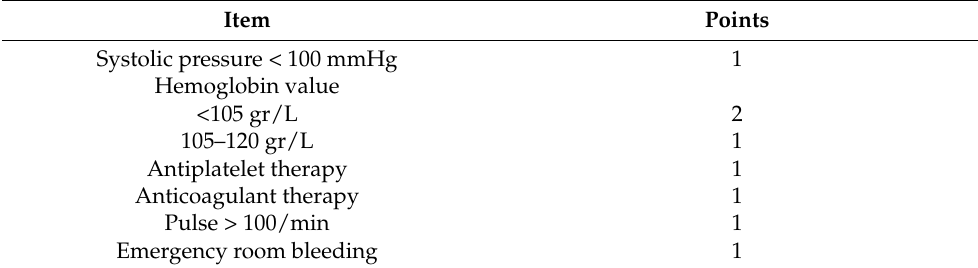
Table A1. SHA 2 PE